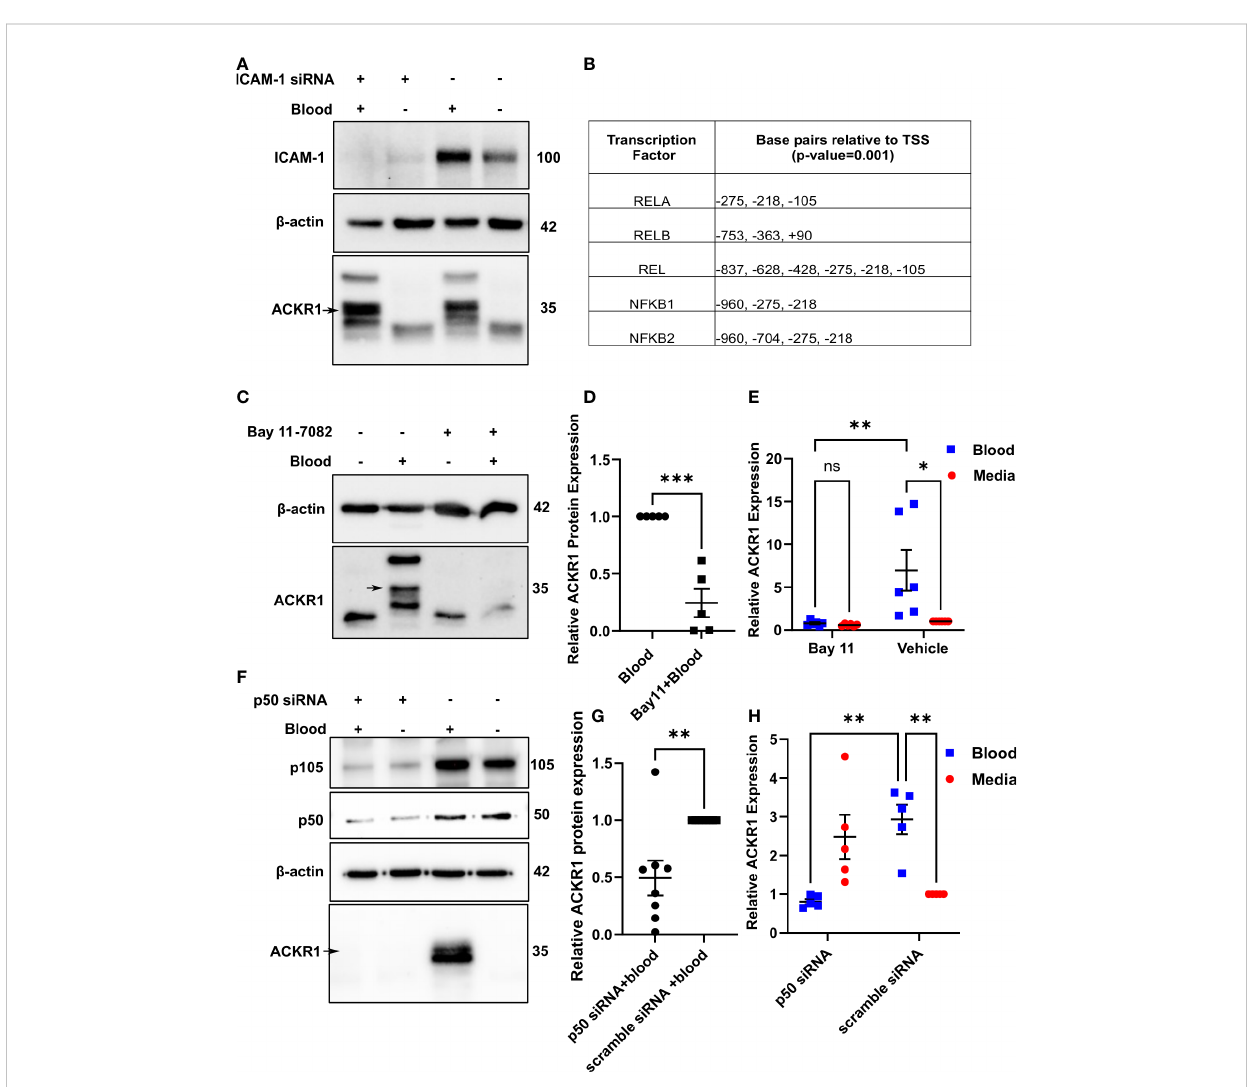
FIGURE 3 Neutrophils induce endothelial ACKR1 through NF- k B. (A) Lung endothelial cells were depleted of ICAM-1 by siRNA followed by incubation with blood for 6 hours. Immunoblotting of whole cell lysates for ACKR1 using the NBP2-75197 antibody was performed. (B) Table shows selected predicted promoter binding sites for ACKR1 . (C, D) Endothelial cells were pre-treated with the NF- k B inhibitor Bay 11-7082 for 30 minutes followed by incubation with blood for 6 hours. Lysates were probed for ACKR1 (representative blot is shown); quanti fi cation in (D) (***p<0.001). (E) qPCR for ACKR1 mRNA under the same conditions (**p<0.01, *p<0.05). (F – H) Endothelial cells were depleted of p50 by siRNA followed by incubation with blood for 6 hours; ACKR1 protein (F) and quanti fi cation in (G) ; **p<0.01) and mRNA (H) ; **p<0.01) are